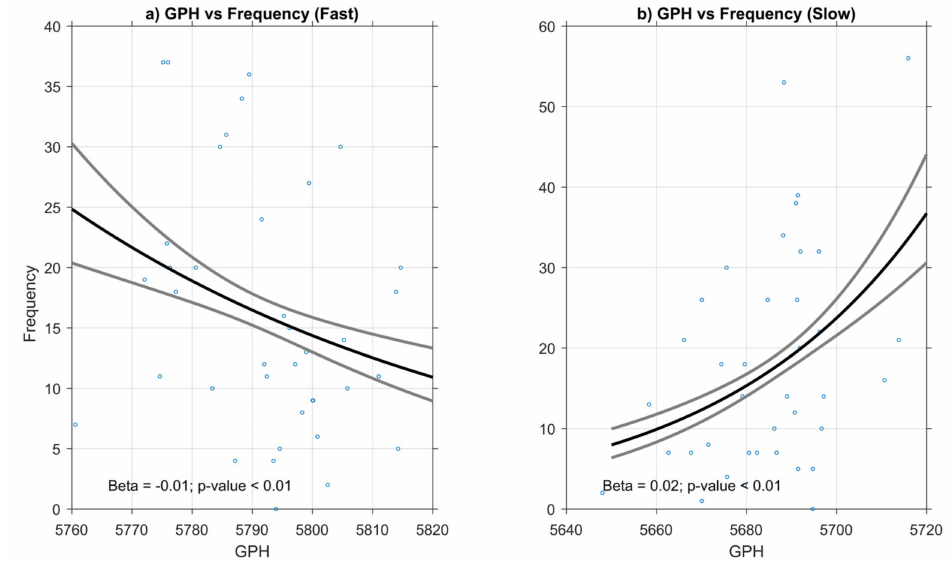
Figure 7. Scatterplot between 500-hPa geopotential height and the frequency of fast- and slow- translation events during June–November (dot). Black curves represent the fitted frequency and grey curves represent the 95th confidence level of the fitted